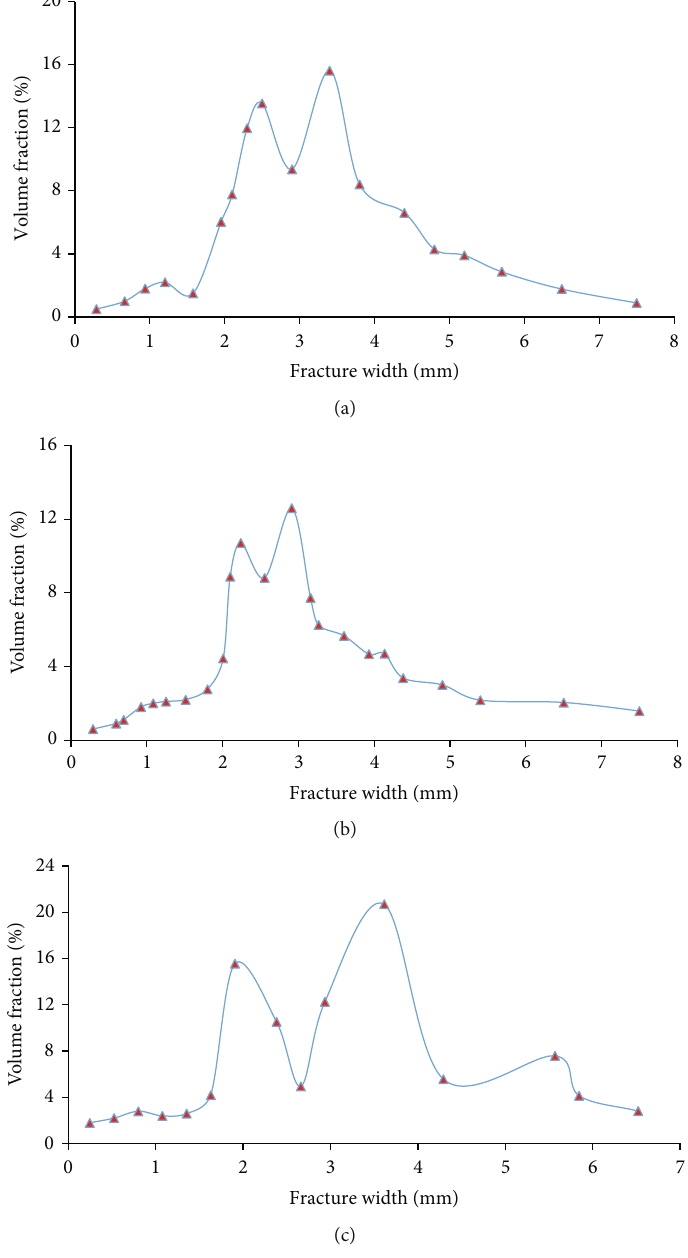
Figure 11: The fracture width of samples 1 (a), 2 (b), and 3